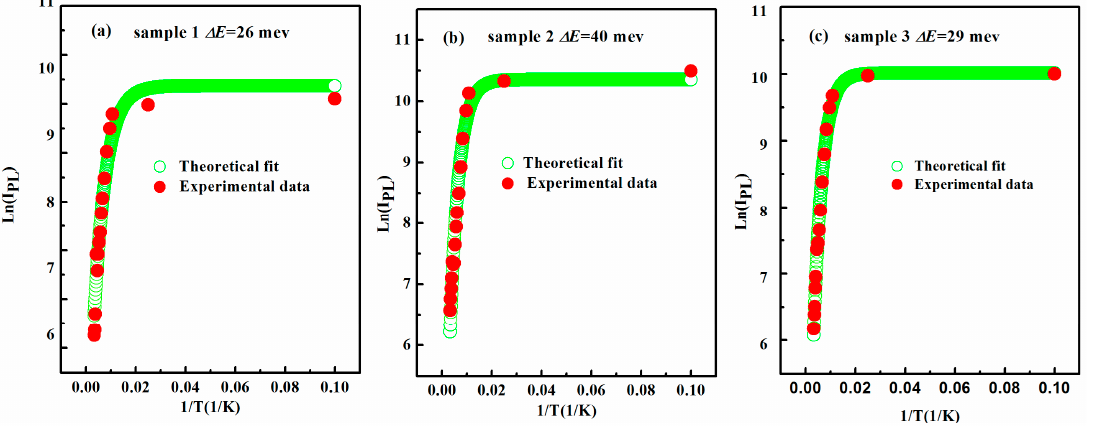
Figure 7. PL intensity for the samples with various Al content as a function of inverse temperature. Corresponding Arrhenius plots are shown by green open circle. ( a ) sample 1; ( b ) sample 2; and ( c ) sample 3.